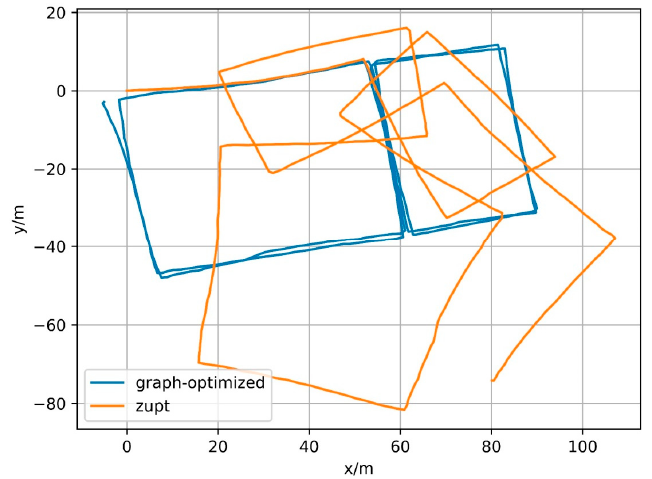
Figure 21. Results of Path B.